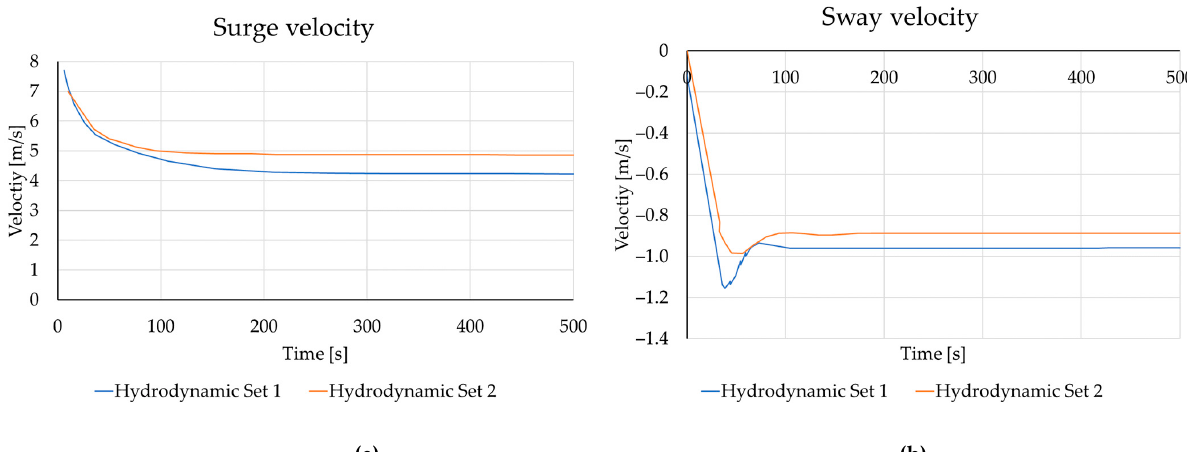
Figure 10. Turning circle test: ( a ) Surge velocity, ( b ) Sway velocity.